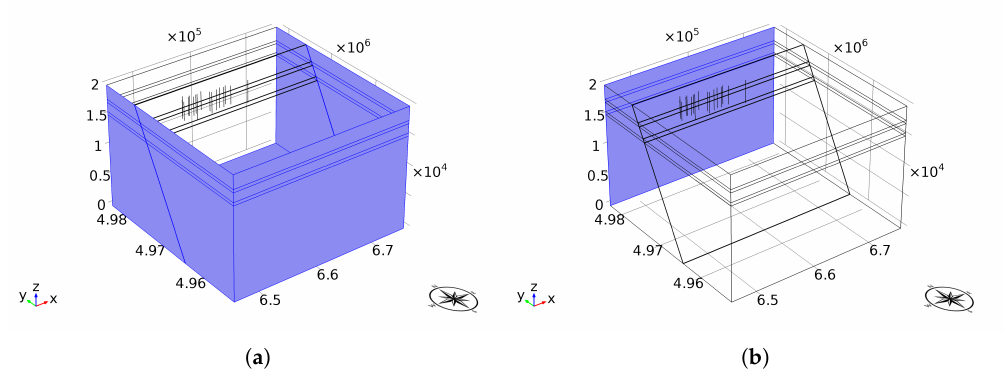
Figure 14. Boundary conditions: Surfaces highlighted in blue are subjected to: rollers restraints ( a ), and boundary loads ( b ); dimensions are in meters (10 5 in x -, 10 6 in y - and 10 4 in z